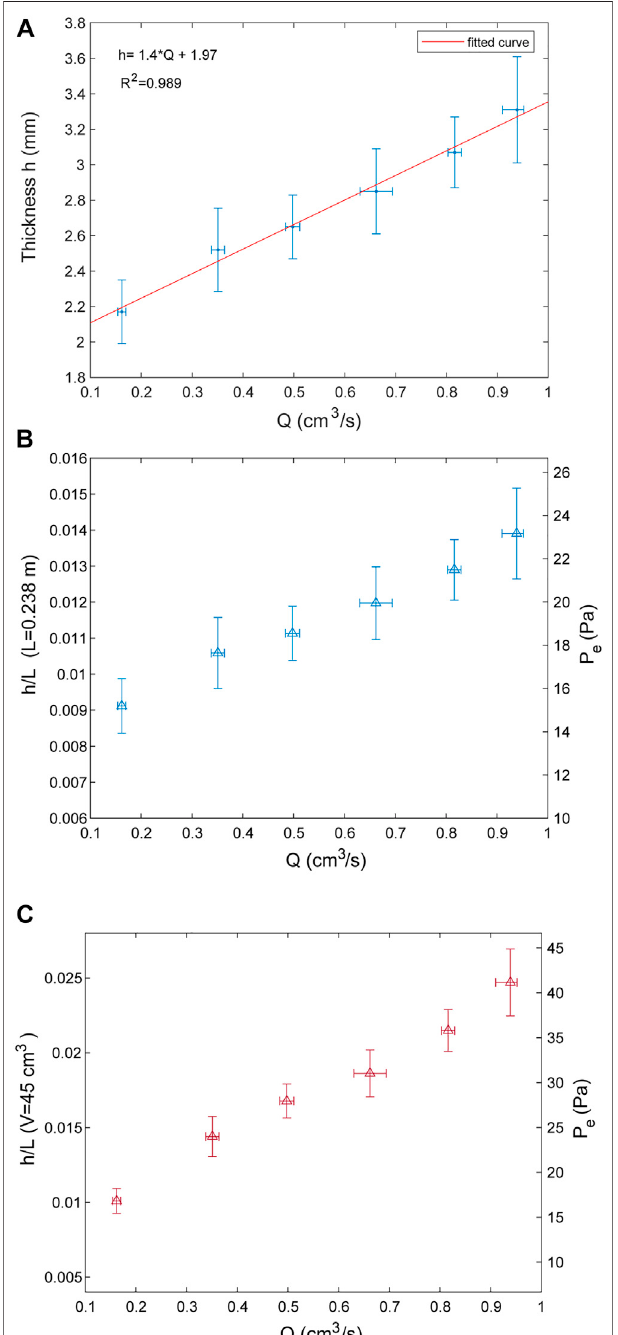
FIGURE 4 | (A) Thickness of the dike as a function of the injection rate (Q). (B) Variation of the thickness/length ratio (h/L) and the associated P e as a function of the injection rate (Q). In each experiment h/L and P e have been calculated when the dikes reach the same length (L (cid:1) L b (cid:1) 0.238 m; see equation 6) (C) Variation of h/L and P e as a function of Q, calculated by intruding the same amount of Volume (V (cid:1) 45 cm 3 ).